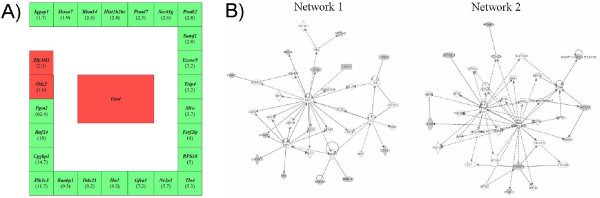
Down-regulation of Oct-4 expression in MIINSN oocytes induces the up-regulation of a group of Oct-4-regulated genes associated with gene expression networks involved in the activation of adverse pathways. (A) Twenty-five Oct-4-regulated genes present in the list of regulated genes determined with our microarray analysis. Twenty-three of them are up-regulated (green square), two are down-regulated (red square). Within each square the name of the gene and the n-fold up- or down-regulation are reported. (B) The two top gene expression networks generated when IPA was interrogated with the list of these 25 Oct-4-regulated genes. Grey symbols are focus genes (use the zoom in tool to enlarge the networks).